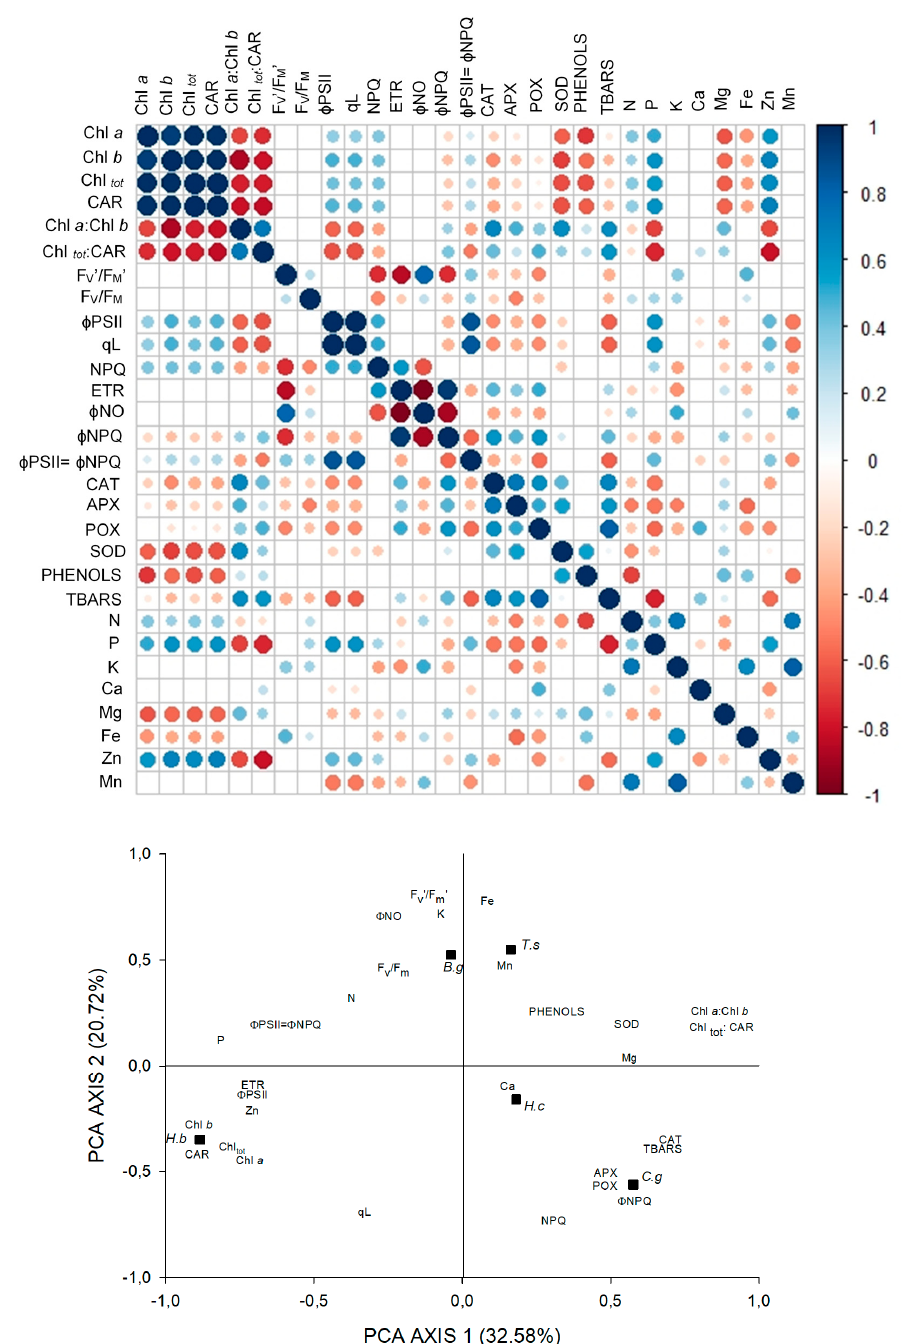
Figure 4. Correlations between pigments content, fluorescence parameters, antioxidant enzymatic activity, phenolic compounds, lipid peroxidation, and foliar concentration of nutrients in six tree species in deep shade, and principal components analysis of the 29 variables studied. Black squares represent the species: Hymenea courbaril (H.c); Carapa guianensis (C.g); Hevea brasiliensis (H.b); Tabebuia serratifolia (T.s); Bellucia grossularioides (B.g), and Ochroma pyramidale (O.p).